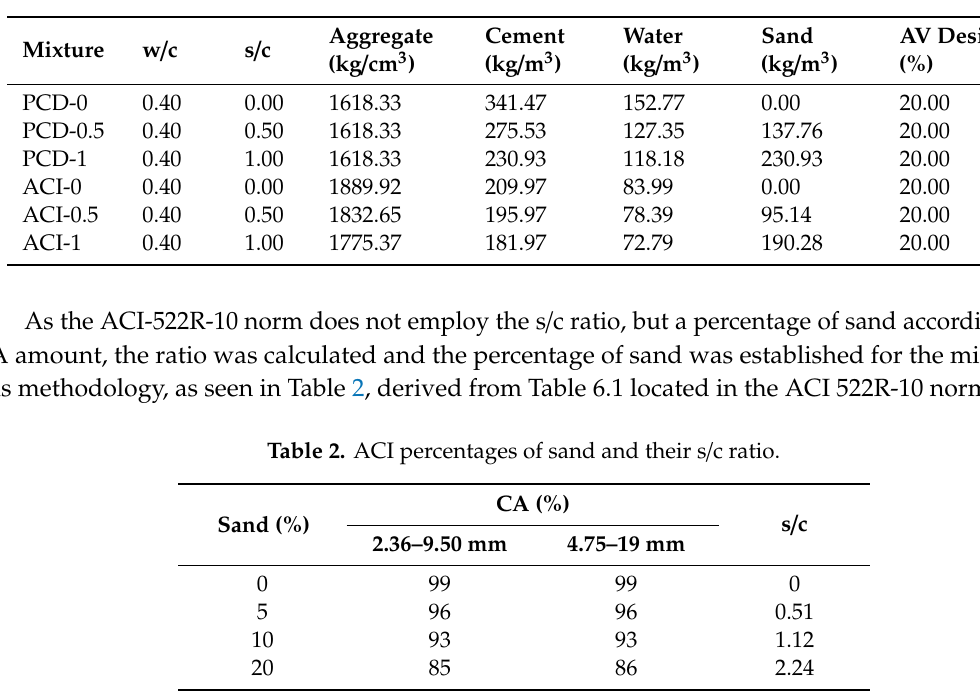
Table 1. Mixture dosages design for the methodologies in study.